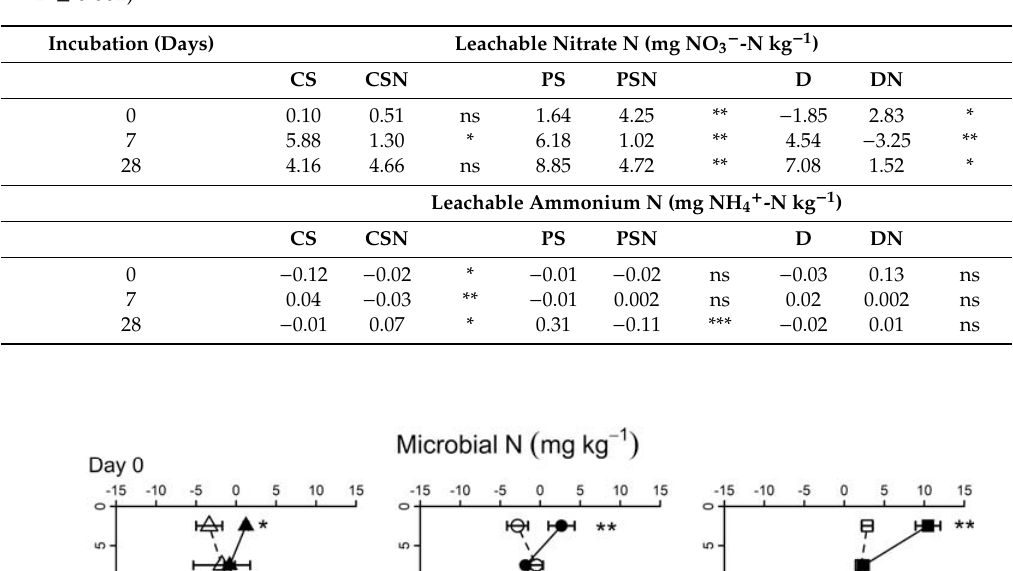
Table 4. Means of the net concentrations of nitrate and ammonia N measured after 0, 7, and 28 days of incubation in leachates from the soil columns treated with pig slurry (PS); pig slurry plus N-Lock TM (PSN); cattle slurry (CS); cattle slurry plus N-Lock TM (CSN); digestate (D); and digestate plus N-Lock TM (DN). Statistical significance of the di ff erences according to HSD Tukey tests (* P ≤ 0.05; ** P ≤ 0.01; *** P ≤ 0.001).